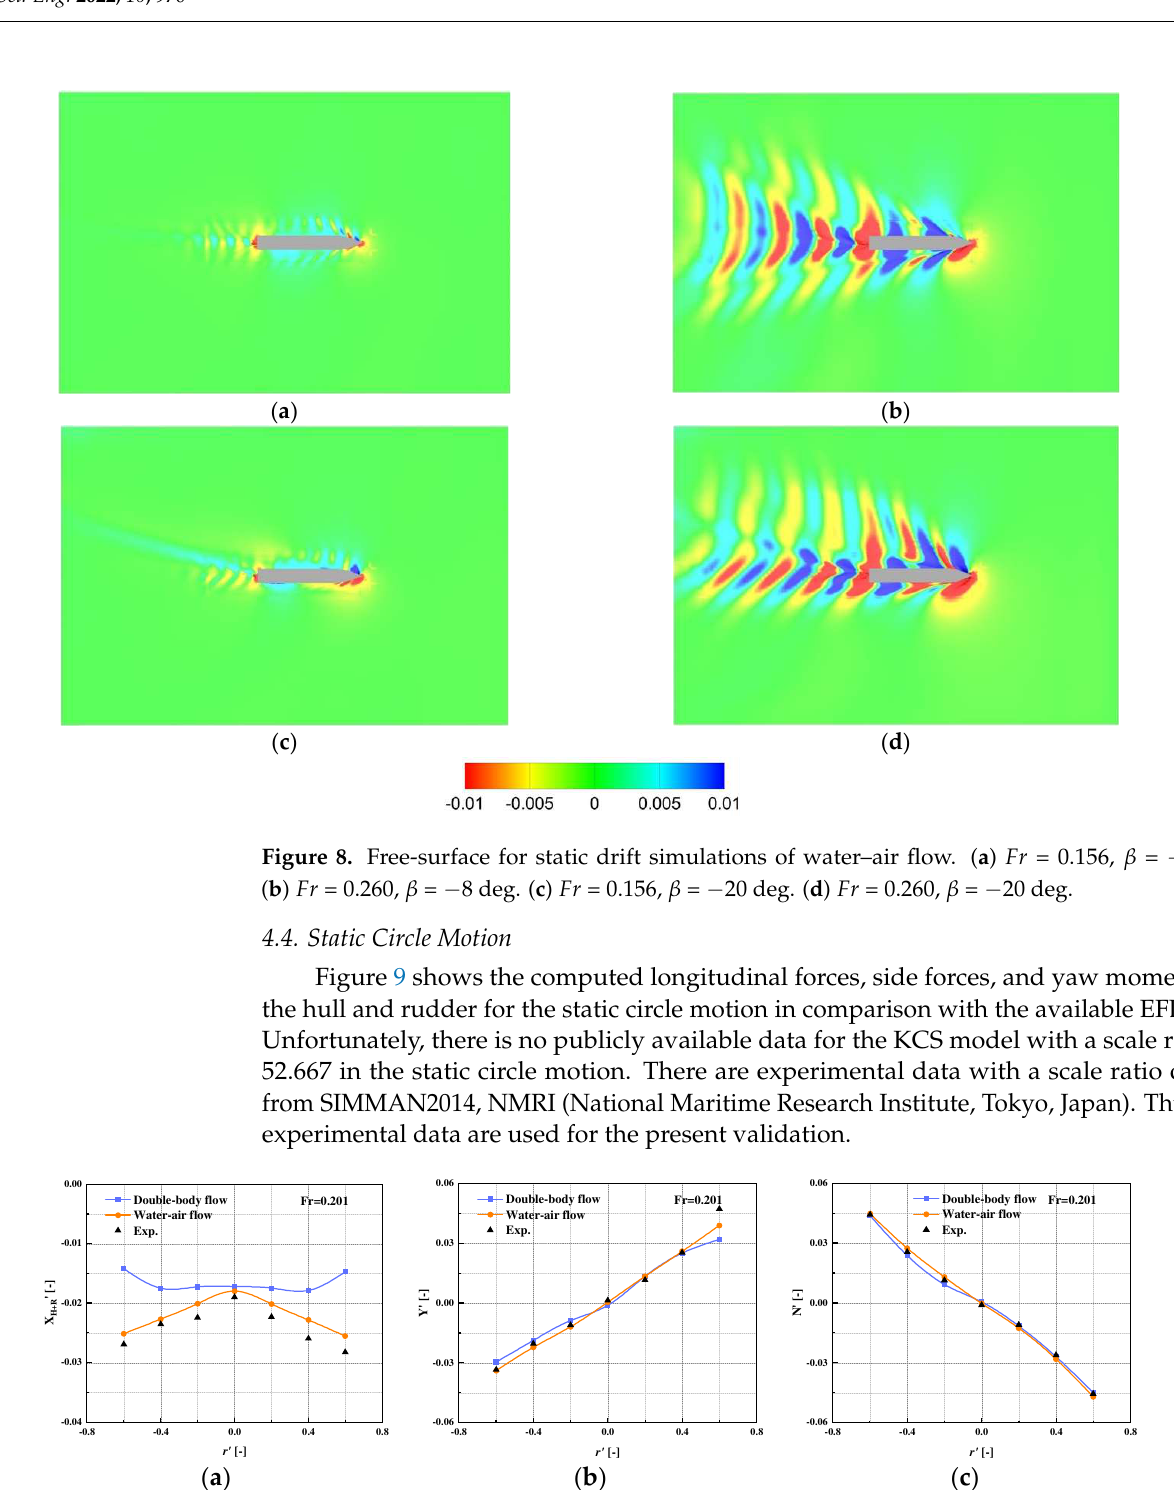
' N . Figure 9. Static turning results of CFD and EFD. ( a ): X